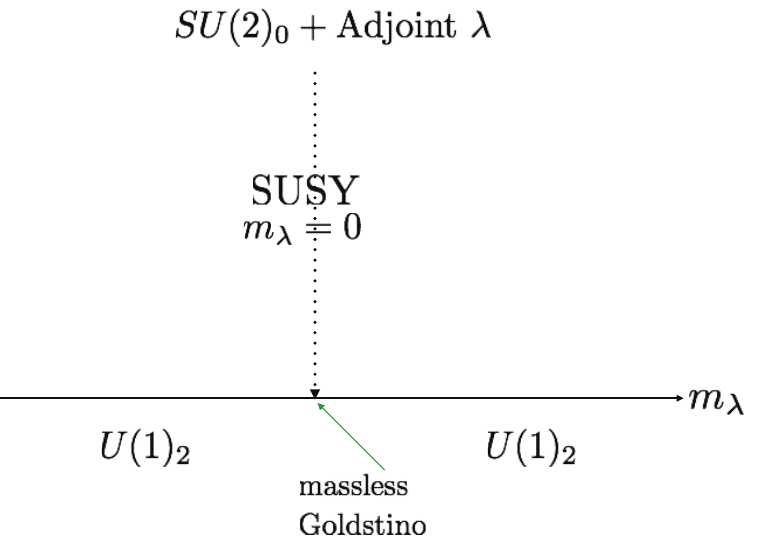
Figure 9: The phase diagram of SU ( 2 ) there are no necessary transitions other than the Goldstino becoming massless at one